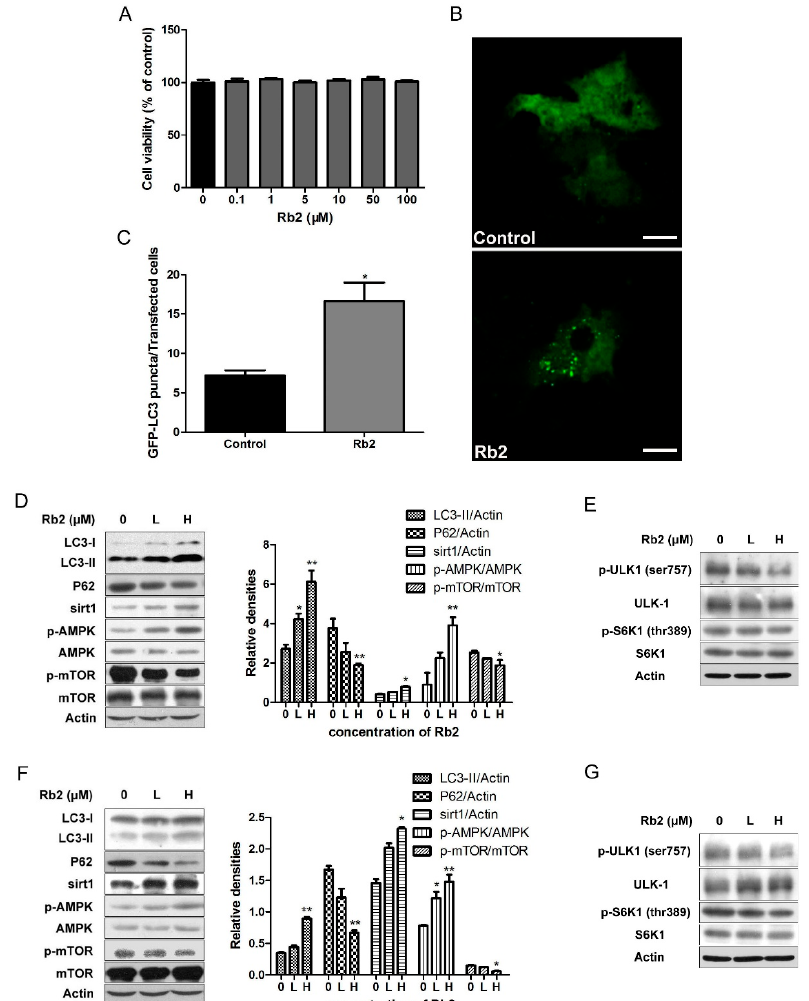
Figure 4. Rb2 dose-dependently stimulated autophagy pathways in hepatocytes. Effect of Rb2 (1, 0.1, 1, 10, 50, and 100 µmol/L) on HepG2 cell ( n = 6) viability ( A ) was determined by 5-diphenyltetrazoliumbromide (MTT). The effect of Rb2 (50 µmol/L) on green fluorescent protein (GFP)-tagged LC3 punctas formation in HepG2 cells was monitored by fluorescence confocal microscopy ( B , Scale bars = 5 µm), and the amount of GFP-LC3 punctas per transfected cell was quantified ( C ). The levels of autophagy marker and regulatory proteins were evaluated by Western blotting analysis after Rb2 (0: Dimethylsulphoxide (DMSO), L: 10 µmol/L, H: 50 µmol/L) treatment for 12 h in HepG2 cells ( D , E ) and primary mouse hepatocytes ( F , G ). Data are expressed as mean ± SE from three independent experiments. * p < 0.05 and ** p < 0.01compared with vehicle (DMSO)-treated group (Control).